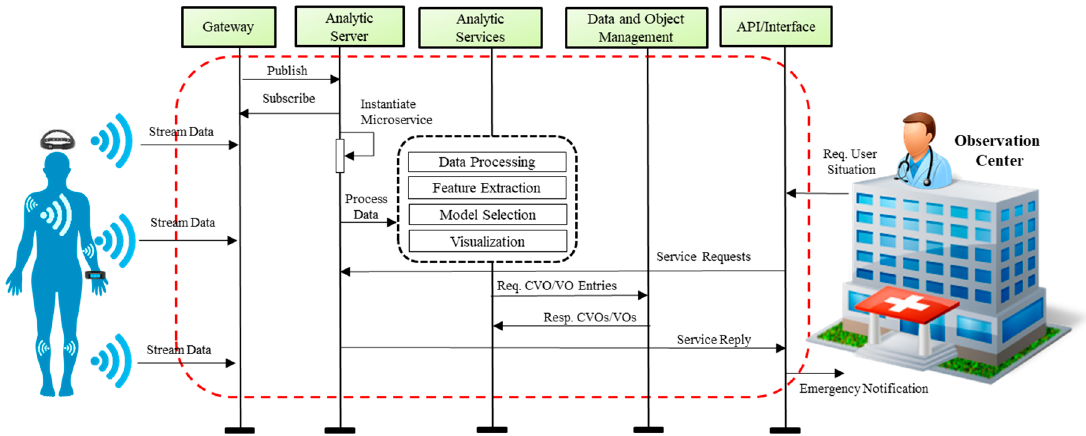
Figure 11. The flow of events for data gathering and analytic service provisioning.